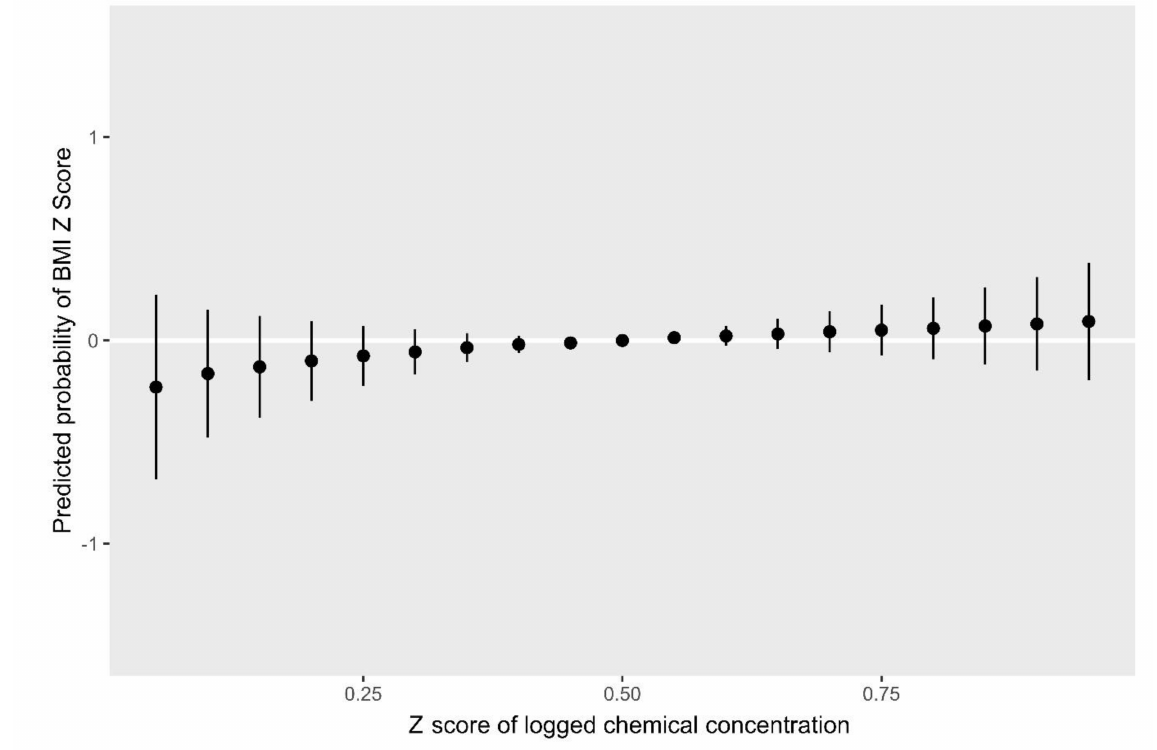
Figure 3. Predicted probability of the body mass index z -score by quantiles of total log2 biomarker concentration z -scores.